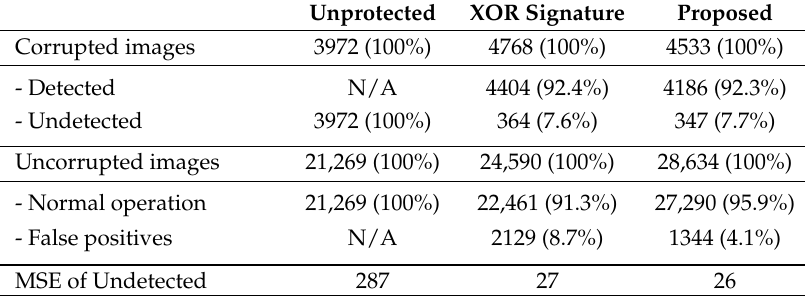
Table 5. Error Detection Report